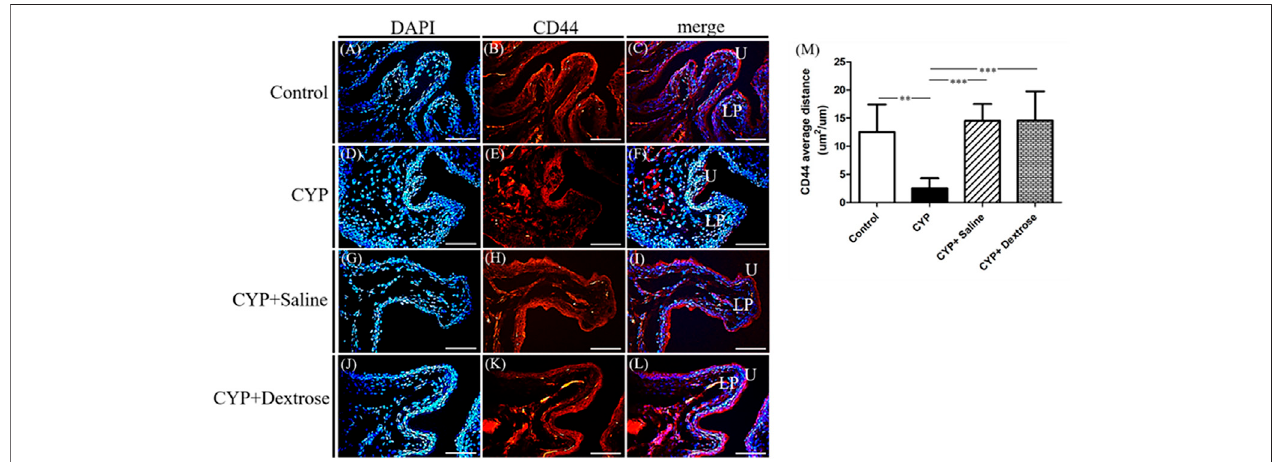
FIGURE 4 | Immuno fl uorescence staining and quantitative analysis of cell surface antigen 44 (CD44) marker of bladder tissues in interstitial cystitis rat model. (A) Control, DAPI; (B) control, CD44; (C) control, merge DAPI + CD44; (D) CYP, DAPI; (E) CYP, CD44; (F) CYP, merge DAPI + CD44; (G) CYP + saline, DAPI; (H) CYP + saline, CD44; (I) CYP + saline, merge DAPI + CD44; (J) CYP + dextrose, DAPI; (K) CYP + dextrose, CD44; (L) CYP + dextrose, merge DAPI + CD44; (M) quantitative analysisofCD44.(CYP (cid:1) cyclophosphamide;DAPI (cid:1) 4 ′ ,6-diamidino-2-phenylindole;U (cid:1) urothelium;LP (cid:1) laminapropria;scalebar (cid:1) 50 μ m;* p ≤ 0.05;** p ≤ 0.01; *** p ≤ 0.001).